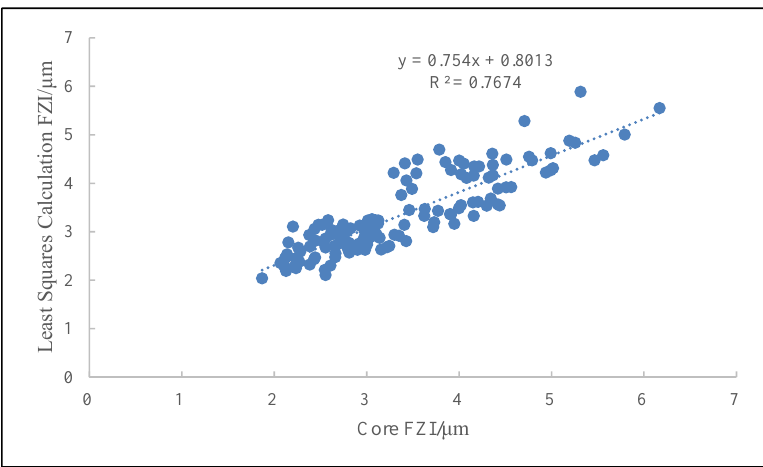
Figure 10. The relationship between core FZI and calculated FZI by least square method.